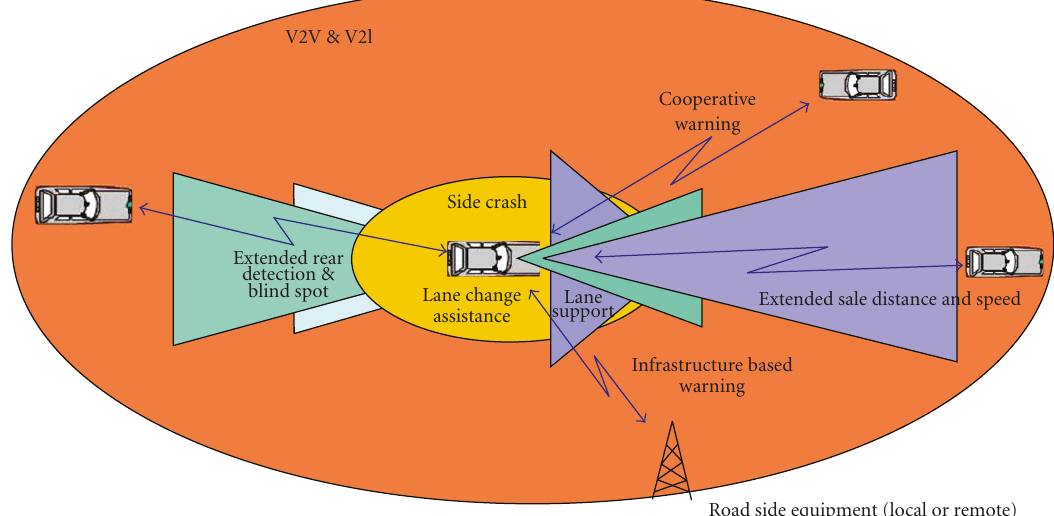
Figure 17: SAFESPOT European Integrated Project Context.